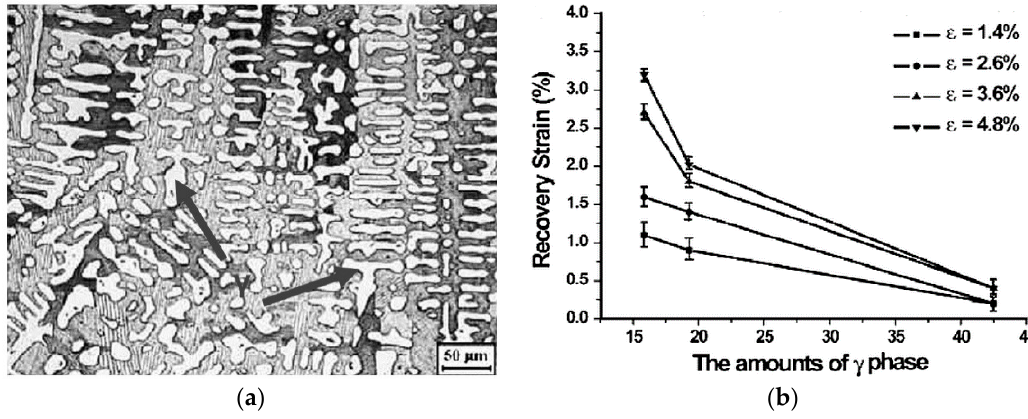
Figure 23. ( a ) Optical micrograph of Ni 56 Mn 17 Co 8 Ga 19 with highest γ phase content; ( b ) shape memory effect in relation to the volume content of γ phase [84], with copyright permission from © Elsevier .